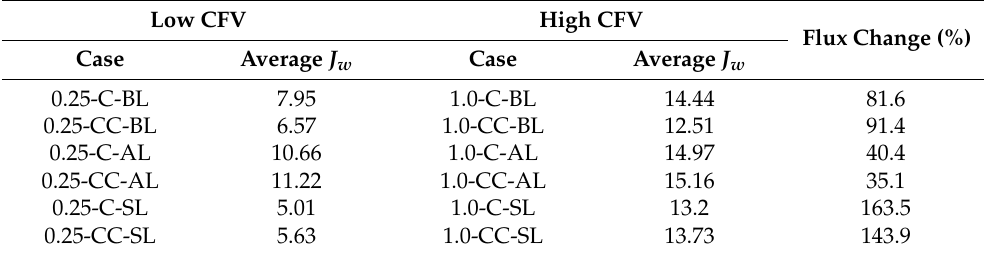
Table 3. Average water flux (L/m 2 · h) at low and high CFV for the investigated cases using NaCl draw solution. Low CFV High CFV